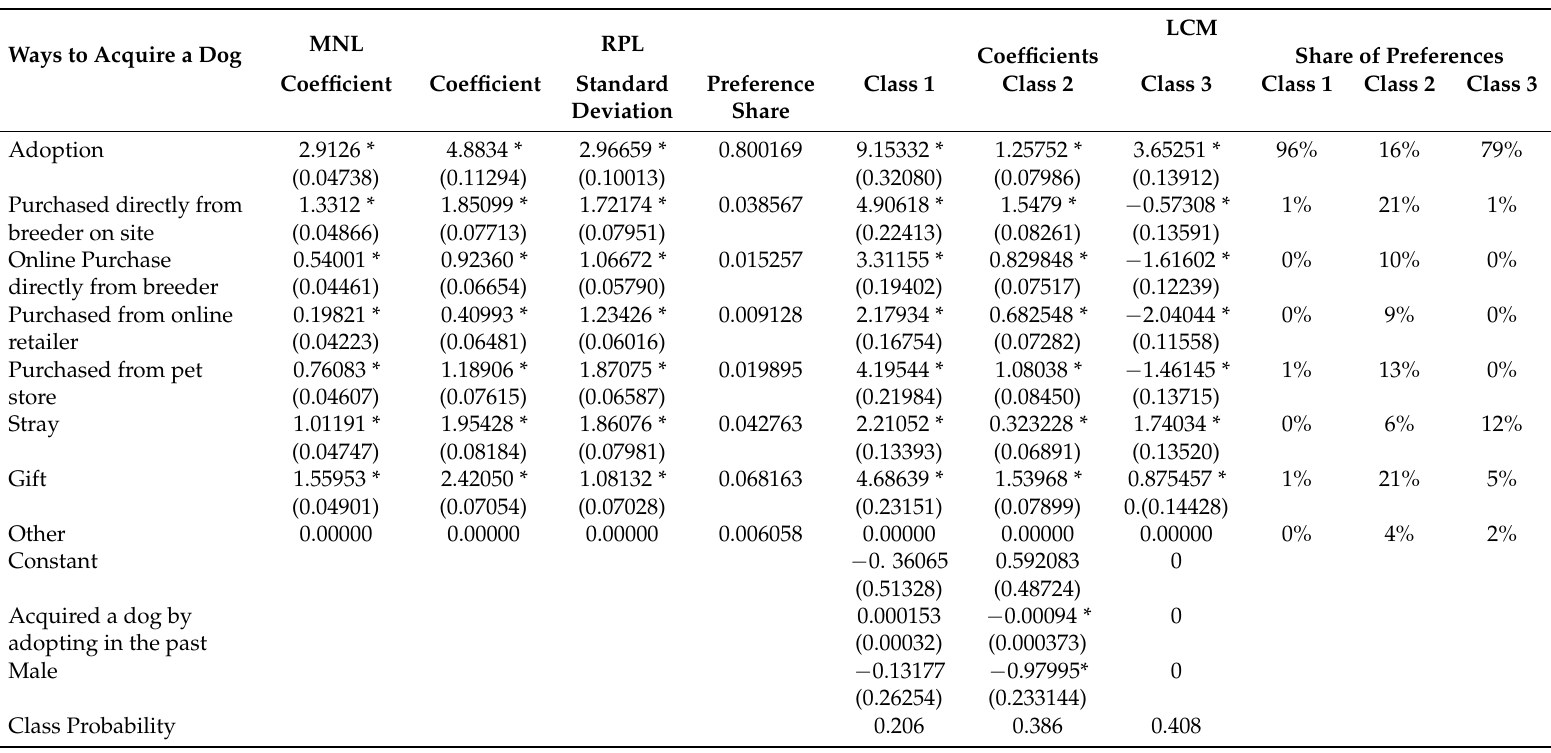
Table 6. MNL, RPL, and LCM) results and derived preference shares for relative ranking of the perceptions of ethical acquisition methods by respondents. * indicates statistical